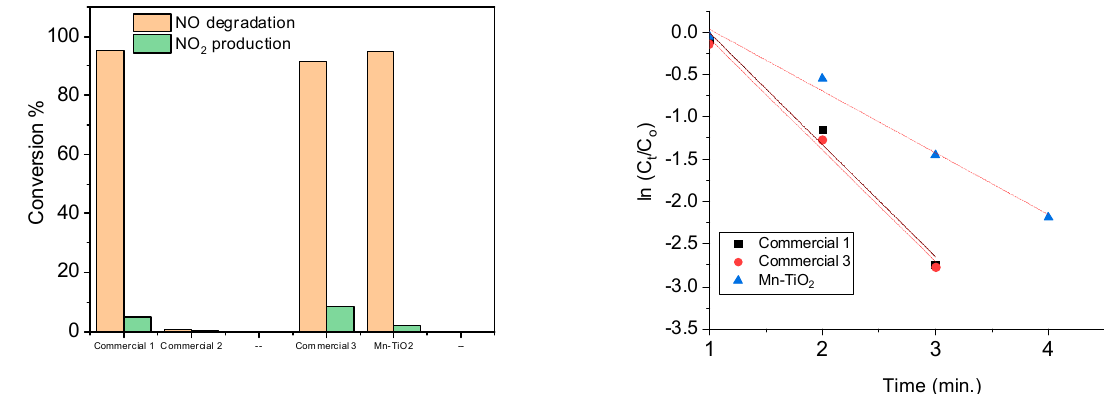
Figure 8. Degradation of NO under visible light illumination utilizing a number of commercial products.